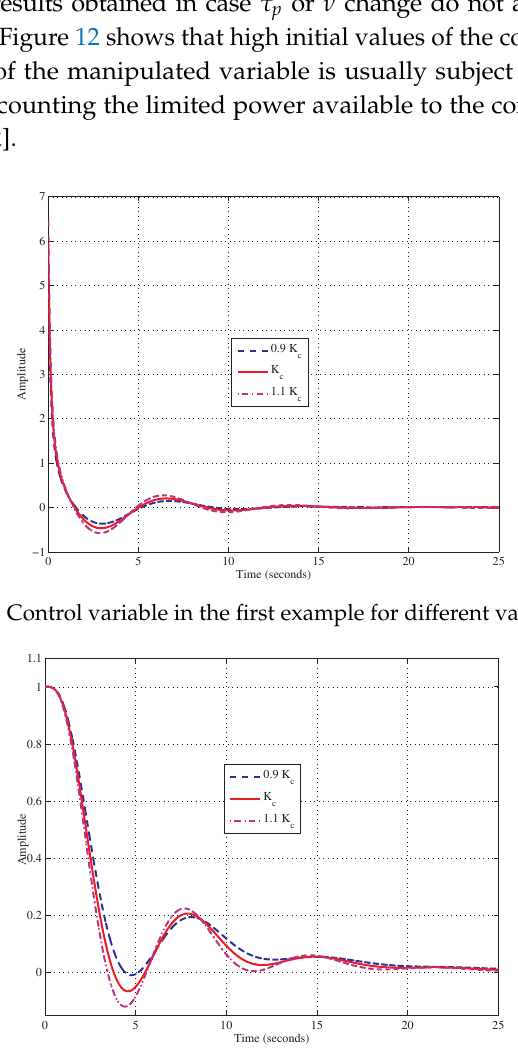
Figure 13. Step disturbance rejection in the first example for different values of K c